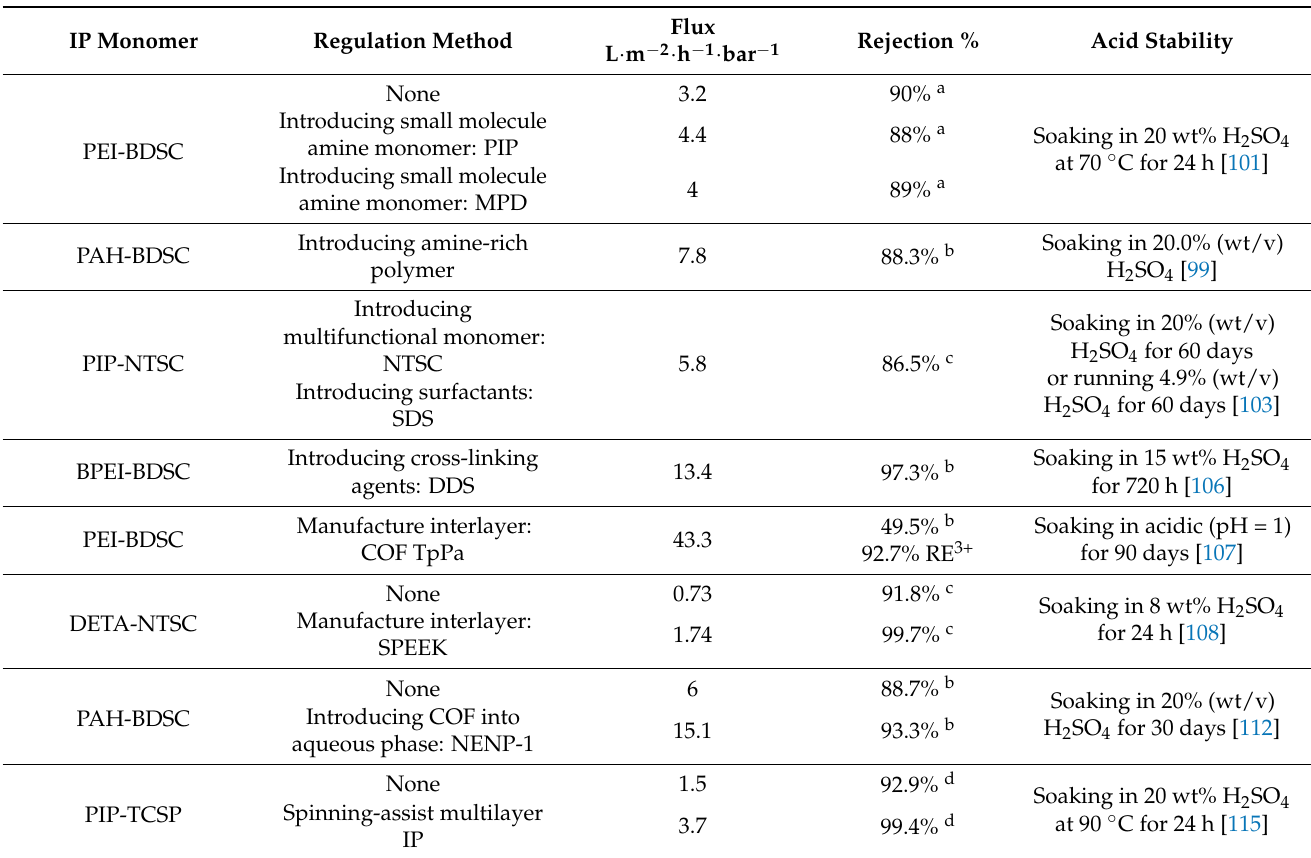
Table 2. Regulation method and acid stability of PSA NF